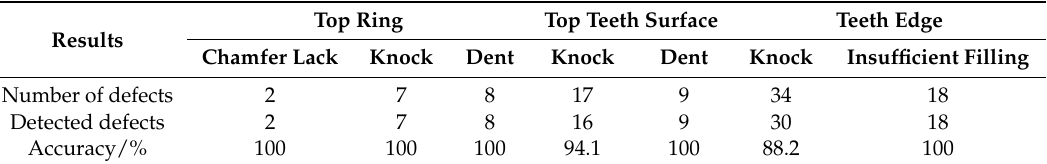
Table 5. Top surface inspection of gear F 6 .